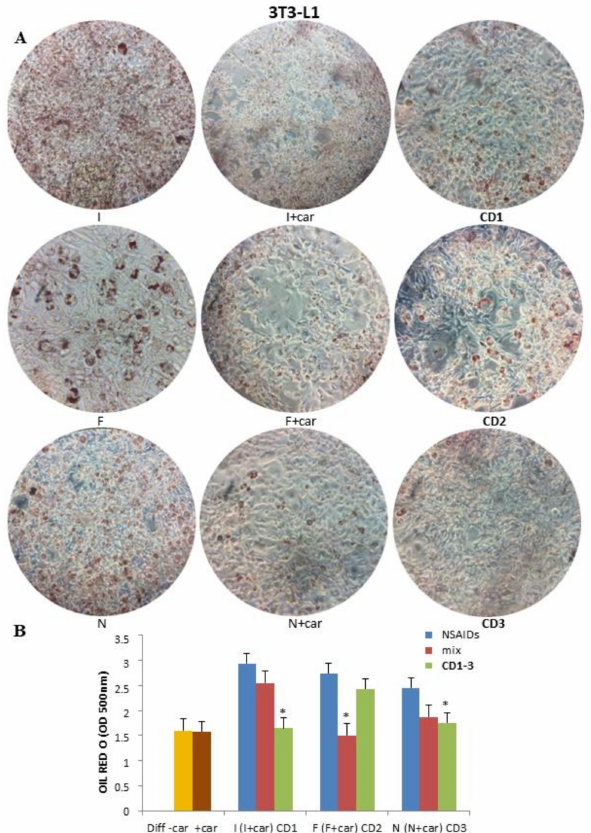
Figure 1. Effect of CD1-3 on adipocyte differentiation in 3T3-L1 cells. ( A ) 3T3-L1 preadipocytes were cultivated in an adipogenic differentiation medium and treated with NSAIDs alone, a physical mixture of selected NSAID and 25 µ M Car, and CD1-3 . ( B ) The visualization of triglyceride accumulation was conducted by Oil Red O staining. Lipid accumulation was observed and measured at 5 days of differentiation by spectrophotometry. Data are produced as the mean ± SD ( n = 3). * p < 0.05: treated cells vs. control (diff − Car) and Car (diff +